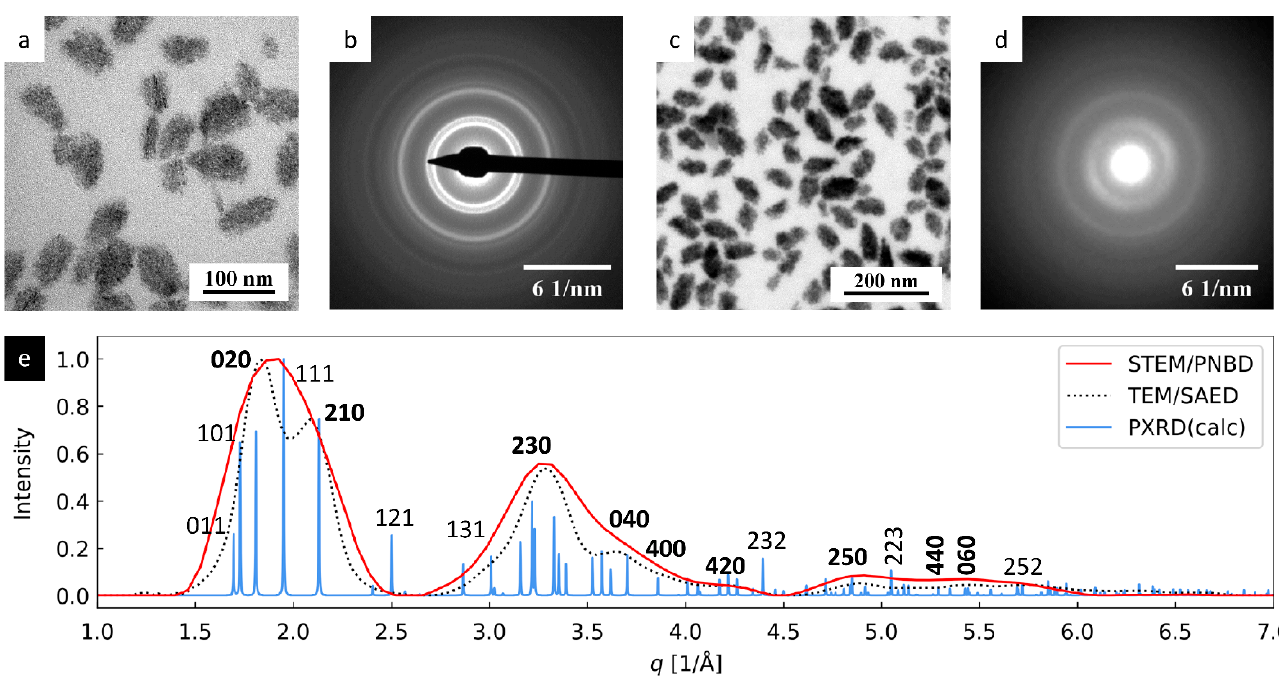
Figure 4. 4D-STEM/PNBD results for TbF 3 nanocrystals and their comparison with TEM and PXRD results: ( a ) TEM/BF image, ( b ) TEM/SAED diffraction pattern, ( c ) STEM/BF image, ( d ) 4D-STEM/PNBD diffraction pattern, and ( e ) comparison of radially averaged results from 4D-STEM/PNBD (red line), TEM/SAED (black dotted line), and theoretically calculated PXRD diffraction pattern of TbF 3 . The hk0 diffraction peaks, which were stronger in TEM/SAED and 4D-STEM/PNBD than in PXRD due to preferred orientation of nanocrystals, are marked with bold font.